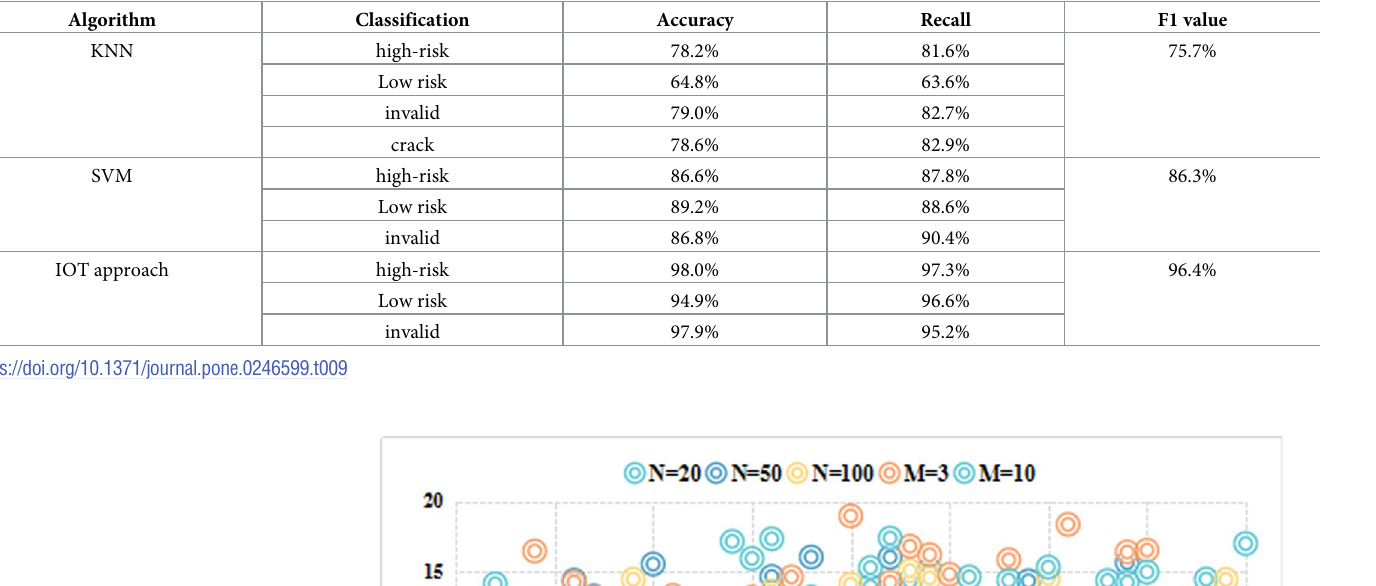
Table 9. Experimental classification results.